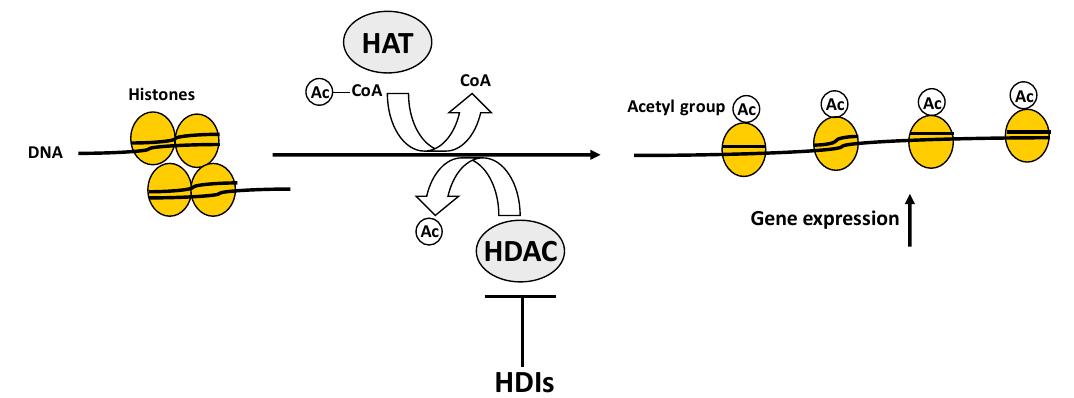
Figure 3. Schematic representation of the role of histone acetyltransferases (HATs) and histone deacetylases (HDACs). HATs induce histone acetylation by transferring an acetyl group from the acetyl coenzyme A to histone lysine side chains (mostly at histone 3 lysine 4 (H3K4Ac) or histone 3 lysine 9 (H3K9Ac)), inducing the opening of chromatin status and promoting gene transcription. Conversely, HDACs remove the acetyl groups from histones, inducing the closing of chromatin status and blocking gene transcription. Histone deacetylase inhibitors (HDIs) inhibit the catalytic activity of HDACs by directly binding to their catalytic sites.